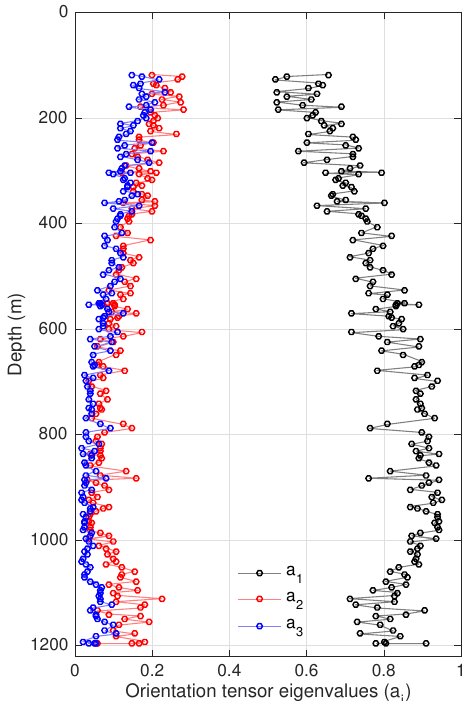
Figure 2. Variation in the eigenvalues, a i , of the second-order ori- entation tensor, (cid:51) , as a function of actual depth. See text for details of a i